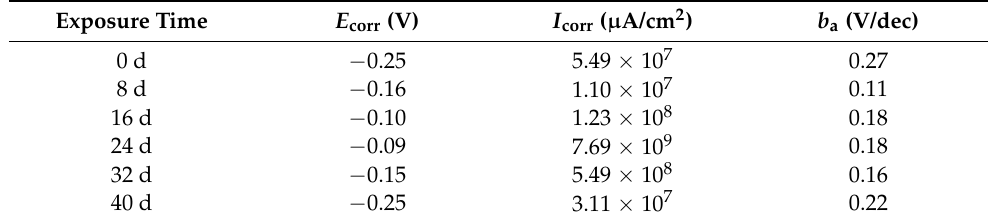
Table 2. Tafel results of potentiodynamic polarization.